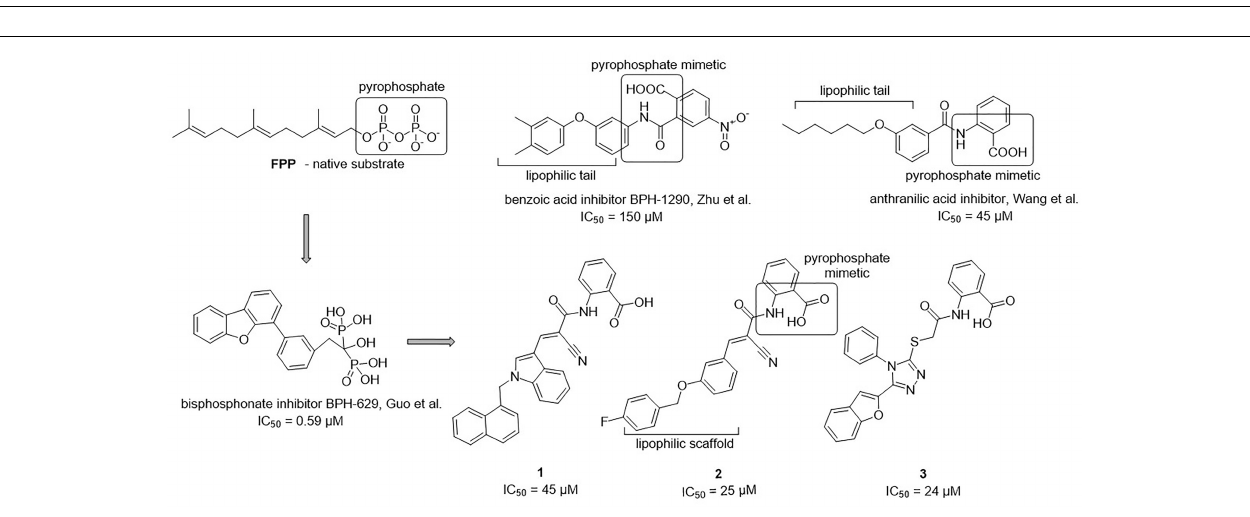
Frontiers in Microbiology |